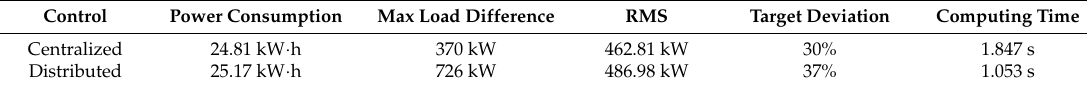
Table 7. The comparison of centralized and distributed